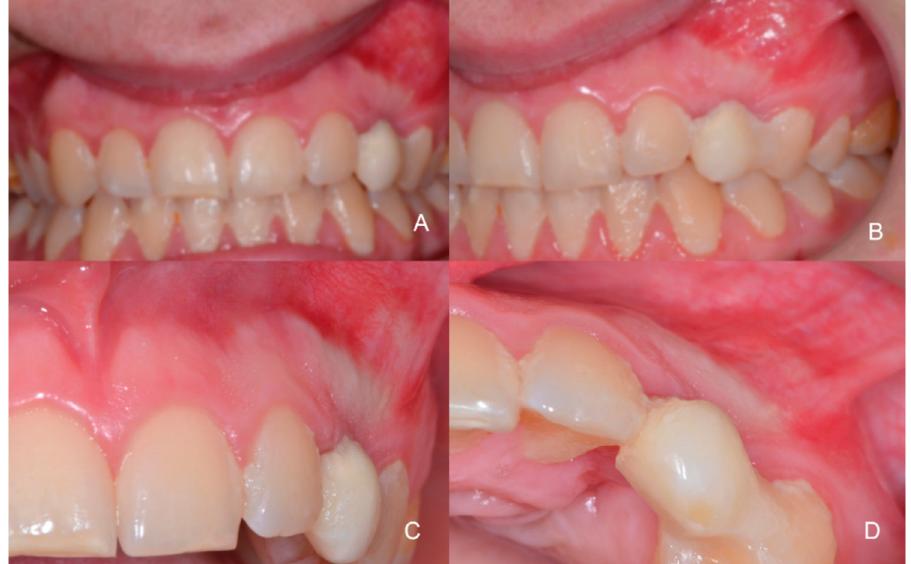
Figure 2. Intra-oral photographic images at baseline. ( A , B ) Front and side view before surgery; ( C , D ) Detail in the lateral and occlusal view with a temporary prosthesis in place 23. An expansion of the bone cortex is visible in line with the odontoma and the permanent area of the canine.